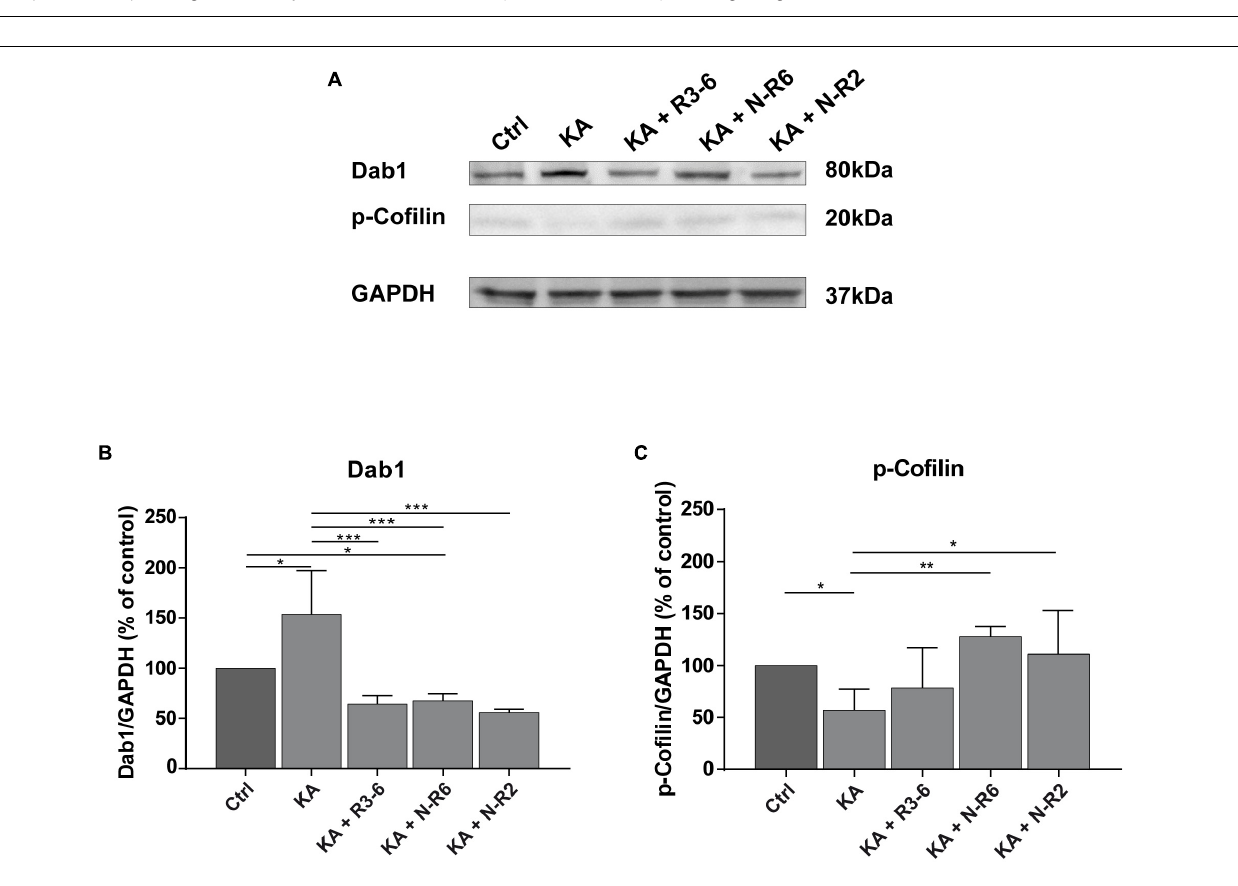
FIGURE 5 | Addition of recombinant Reelin fragments restores KA-mediated alterations of Reelin signaling components. Quantitative Western blot analysis for Dab1, p-cofilin was performed with extracts from control OHSC ( n = 8 animals, 8–10 slices/animal), OHSC treated with 10 µ M KA for 45 min ( n = 3 animals, 8–10 slices/animal) and OHSC exposed to KA followed by incubation with fresh medium and subsequent application of recombinant Reelin fragments: R3-6 ( n = 4 animals, 8–10 slices/animal), N-R6 ( n = 3 animals, 8–10 slices/animal) and N-R2 ( n = 4 animals, 8–10 slices/animal). (A) Representative Western blot for Dab1 and p-cofilin. GAPDH was used as a loading control. (B,C) Densitometric evaluation of (B) Dab1, (C) p-cofilin. Treatment with KA results in a significant upregulation of Dab1 synthesis and reduction of phosphorylated cofilin levels in tissue extracts. Subsequent incubation with the different recombinant Reelin fragments restores Dab1 and p-cofilin levels. One-way ANOVA followed by Tukey’s Multiple Comparison Test (* P < 0.05; ** P < 0.01; *** P < 0.001). Molecular weights are shown in